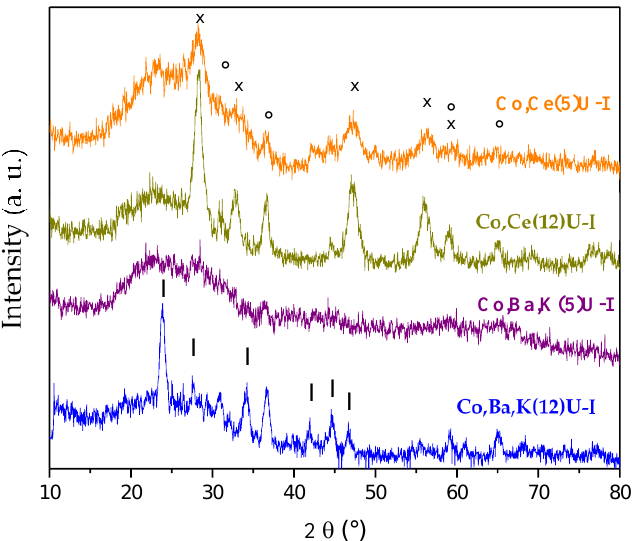
Figure 10. XRD diffraction patterns of catalytic ceramic papers with natural ulexite and with Co,Ce and Co,Ba,K addition. Symbols ( ◦ ) Co 3 O 4 , (x) CeO 2 , and (I) BaCO 3 .